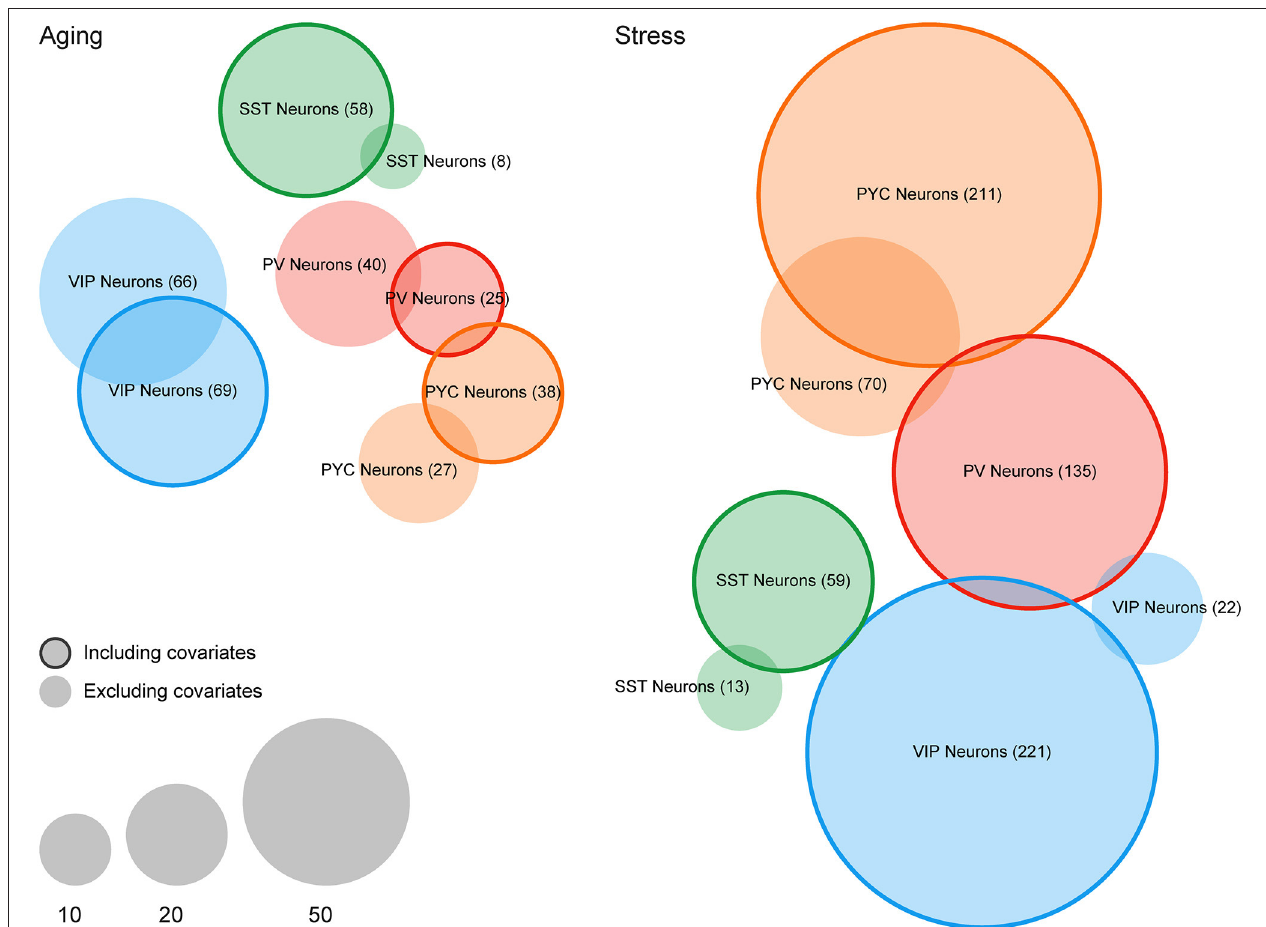
FIGURE 3 | Differential expression analysis of case/condition LCM-seq datasets with and without including covariates for off-target cellular contamination. Venn diagrams indicating the number of differentially expressed genes (FDR < 0.1) in the Aging and Stress datasets. Non-outlined circles indicate counts of differentially expressed genes without including cellular contamination covariates and outlined circles indicate counts following inclusion of covariates. Empty sets (i.e., PV Neurons in the Stress dataset) are not shown.